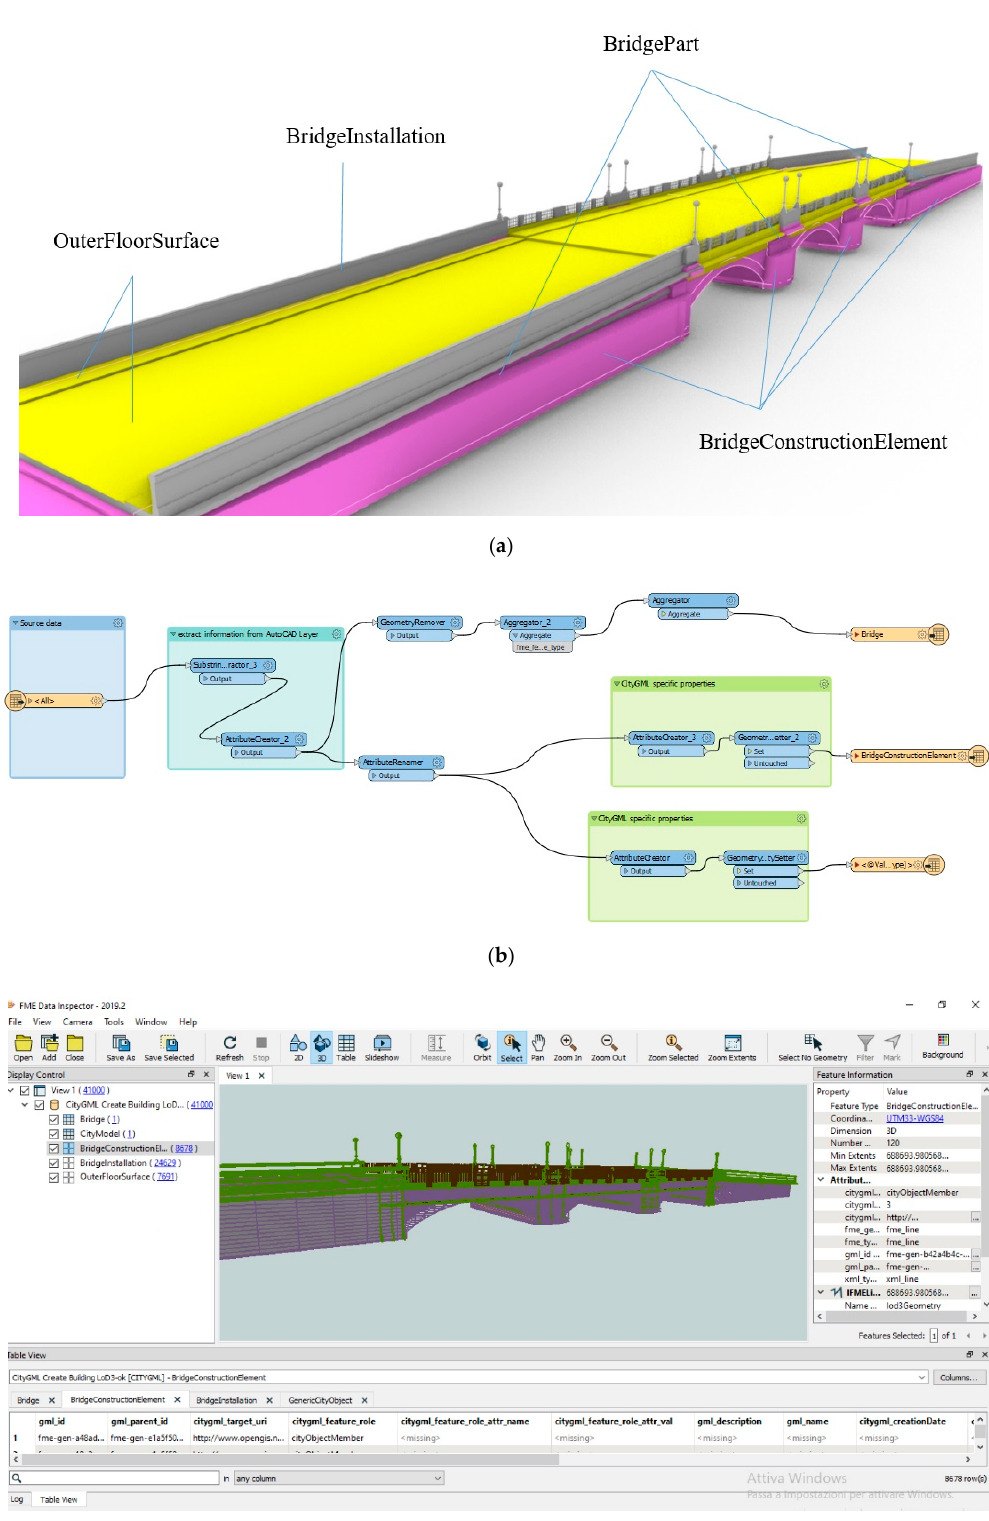
Figure 18. Building CityGML model: ( a ) representation of the different elements of the bridge in CiyGML; ( b ) part of transformation schema in the FME environment to obtain the “building” feature in CityGML format; ( c ) 3D model in FME data inspector.